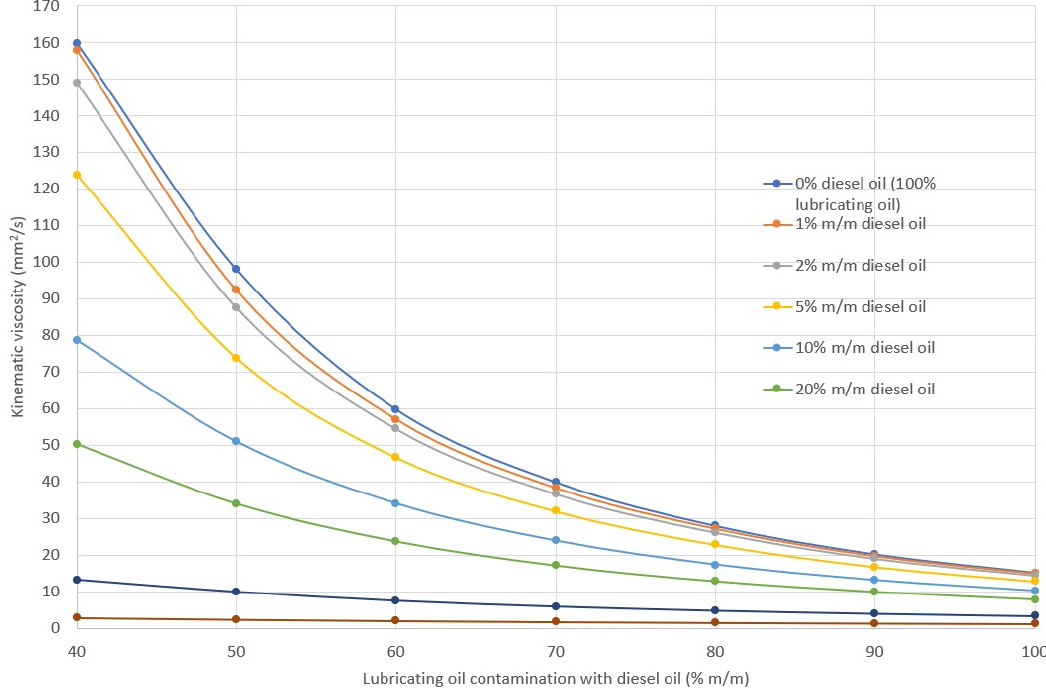
Figure 15. Measured kinematic viscosity values of SAE 40 grade oil in the temperature range of 40–100 °C at different levels of lubricating oil dilution with diesel fuel.